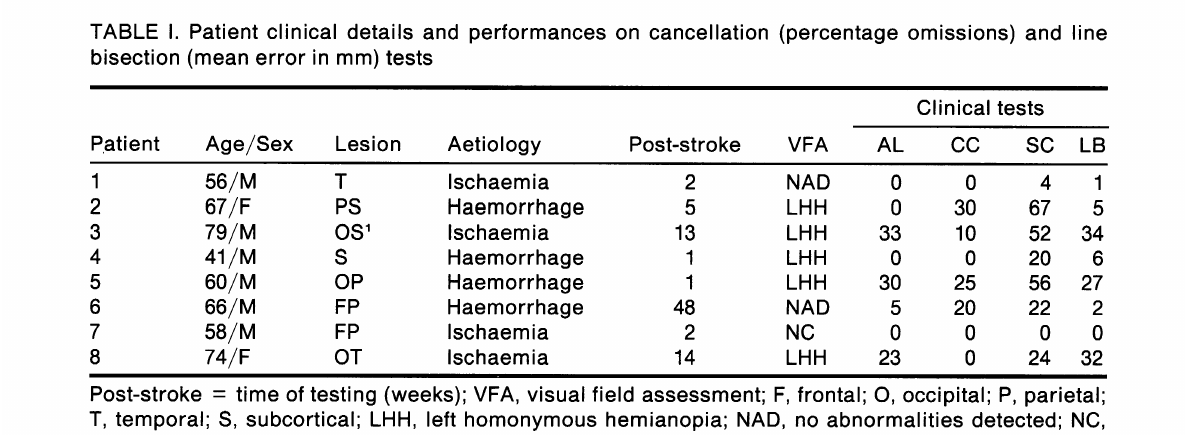
TABLE I. Patient clinical details and performances on cancellation (percentage omissions) and line bisection (mean error in mm)